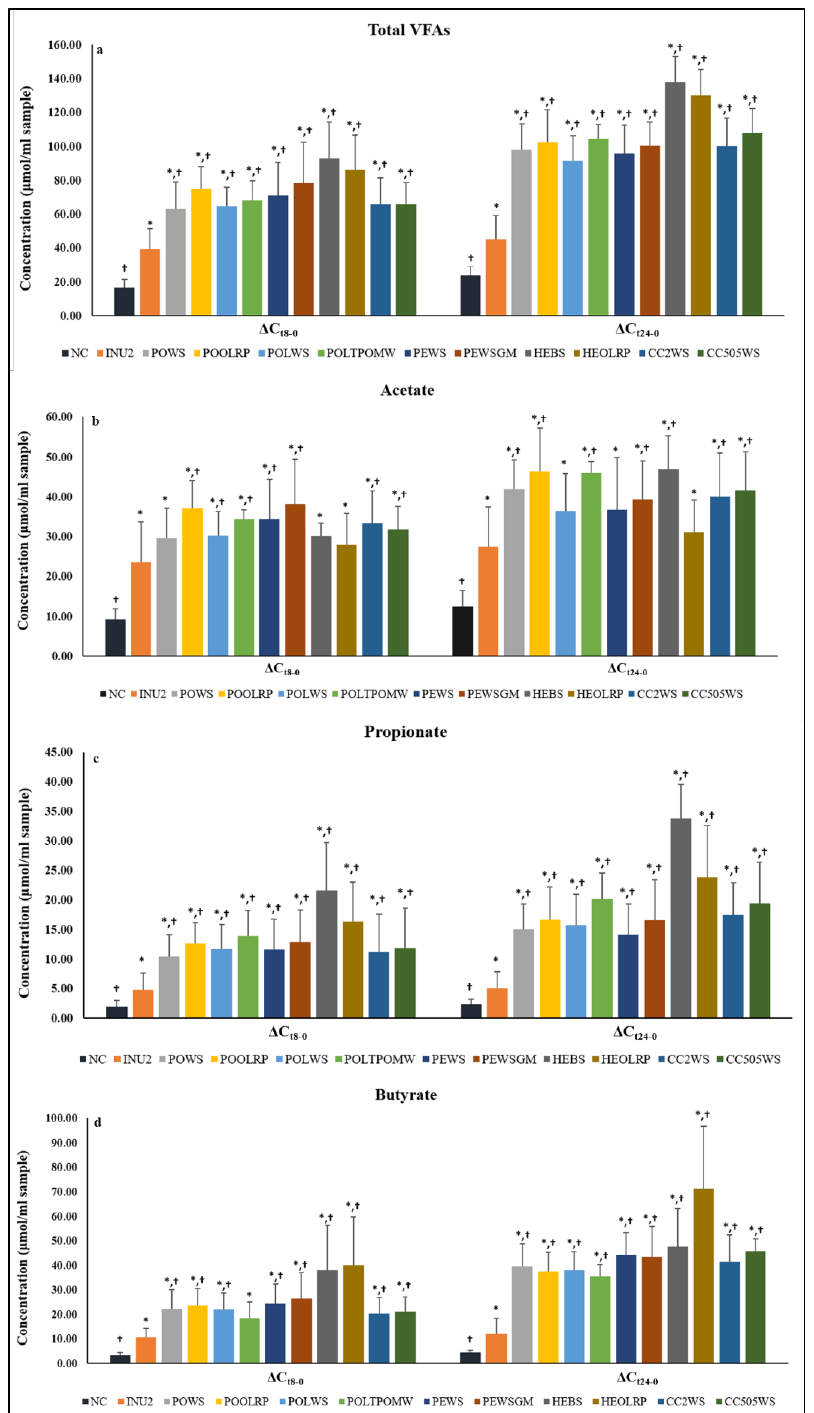
Figure 2. Differences (Δ) in concentrations (μmol mL − 1 ) of ( a ) total volatile fatty acids (VFAs), ( b ) Figure 2. Di ff erences ( ∆ ) in concentrations ( µ mol mL − 1 ) of ( a ) total volatile fatty acids (VFAs), acetate, ( c ) propionate and ( d ) butyrate after 8- h fermentation (ΔCt8 -0) and 24- h fermentation (ΔCt24 - ( b ) acetate, ( c ) propionate and ( d ) butyrate after 8-h fermentation ( ∆ Ct8-0) and 24-h fermentation 0) compared to baseline. Values are expressed as mean and SD, where ΔCt8 -0 is defined as ( ∆ Ct24-0) compared to baseline. Values are expressed as mean and SD, where ∆ Ct8-0 is defined as ‘Concentration t = 8 h minus Concentration t = 0 h’ and ΔCt24 - 0 is defined as ‘Concentration t = 24 h ‘Concentration t = 8 h minus Concentration t = 0 h’ and ∆ Ct24-0 is defined as ‘Concentration t = 24 h minus Concentration t = 0 h’ (for POLTPOMW and HEBS n = 4— for CC2WS and CC505 n = 7); *: minus Concentration t = 0 h’ (for POLTPOMW and HEBS n = 4—for CC2WS and CC505 n = 7); significant difference compared to NC ( p < 0.05) (Mann-Whitney test or t- test);†: significant differen ce *: significant di ff erence compared to NC ( p < 0.05) (Mann-Whitney test or t -test); † : significant di ff erence compared to INU2 ( p < 0.05) (Mann-Whitney test or t-test). compared to INU2 ( p < 0.05) (Mann-Whitney test or t